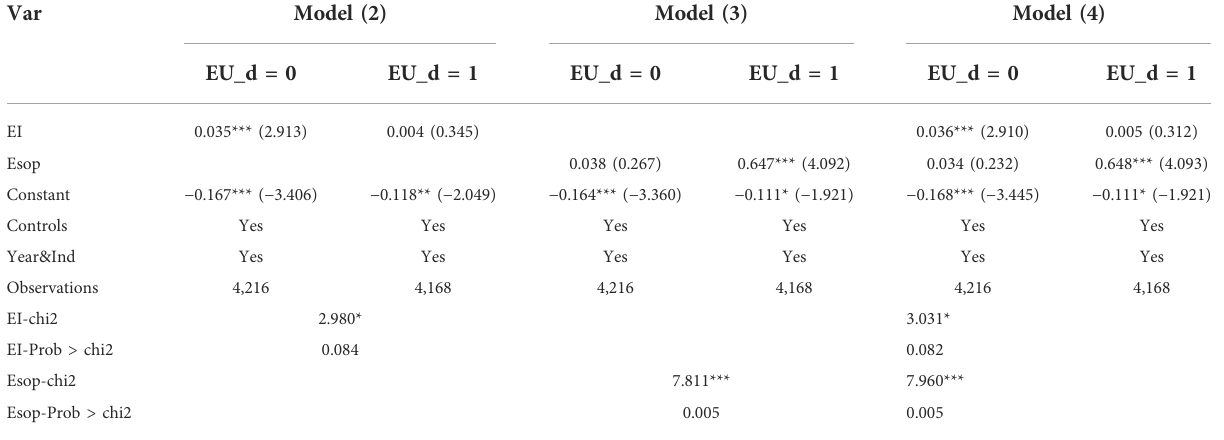
TABLE 5 Grouping test of environmental